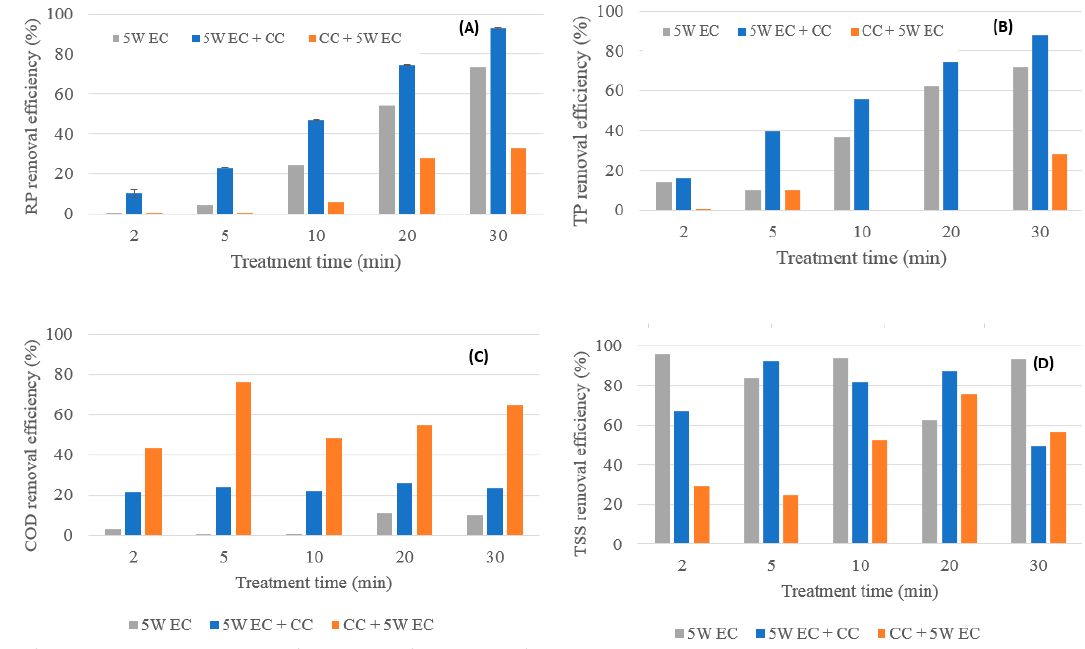
Figure 5. Comparison of removal performance of ECT, ECT and post CCT and CCT and post ECT (5 W); ( A ) RP removal performance, ( B ) TP removal performance, ( C ) COD removal performance, ( D ) TSS removal performance (supernatant). Water 2019 , 11 , x FOR PEER REVIEW